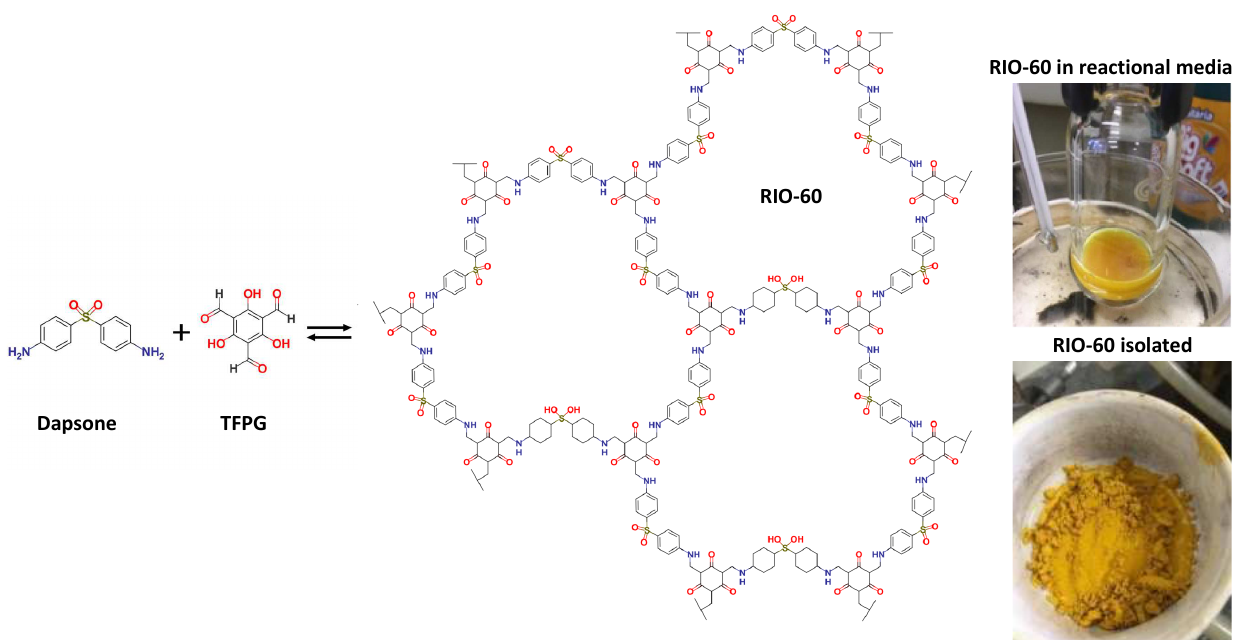
Figure 6. Synthesis of RIO-60. Dapsone is an angled building-block that forms more closed pores and has a structure that is susceptible to crystalline disorders. Additionally, it has interesting properties, such as photoactivity and catalysis.